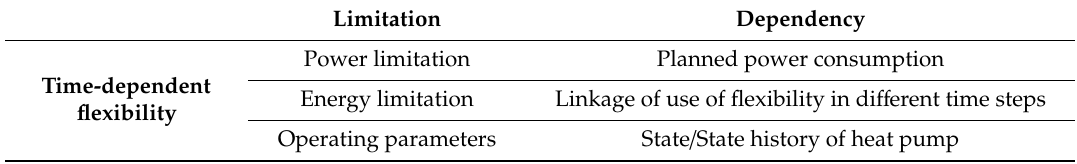
Table 1. Summary of limitations of the time-dependent flexibility of heat pumps.